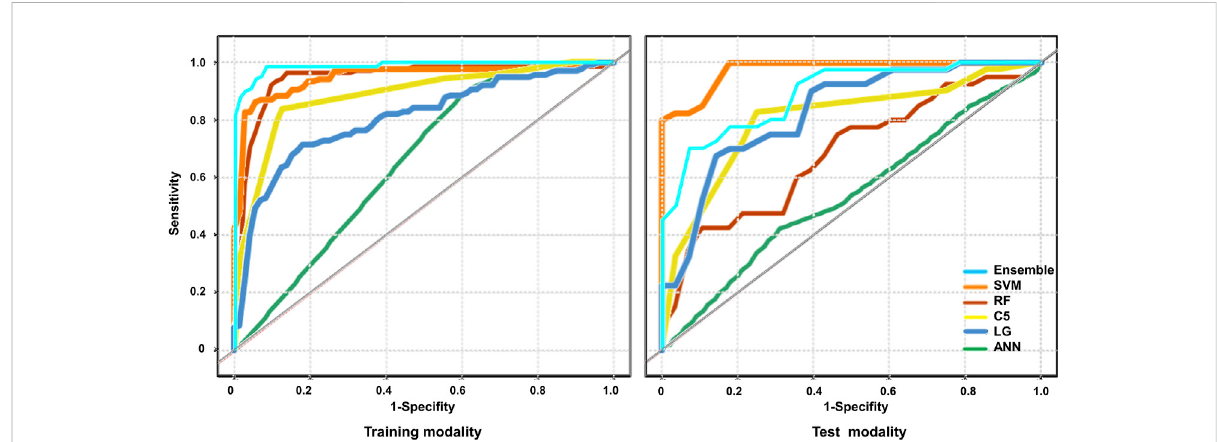
FIGURE 4 The performance of the models for the prediction of renal de fi ciency diagnosed by DMSA/DTPA. The Receiver operating characteristic (ROC) curves of thedifferent models were presented across the training and test cohort. Logistic regression(LR), decision tree (C5.0), SVM, neural network (Nnet), Random Forest (RF) RF and ensemble models were unutilized